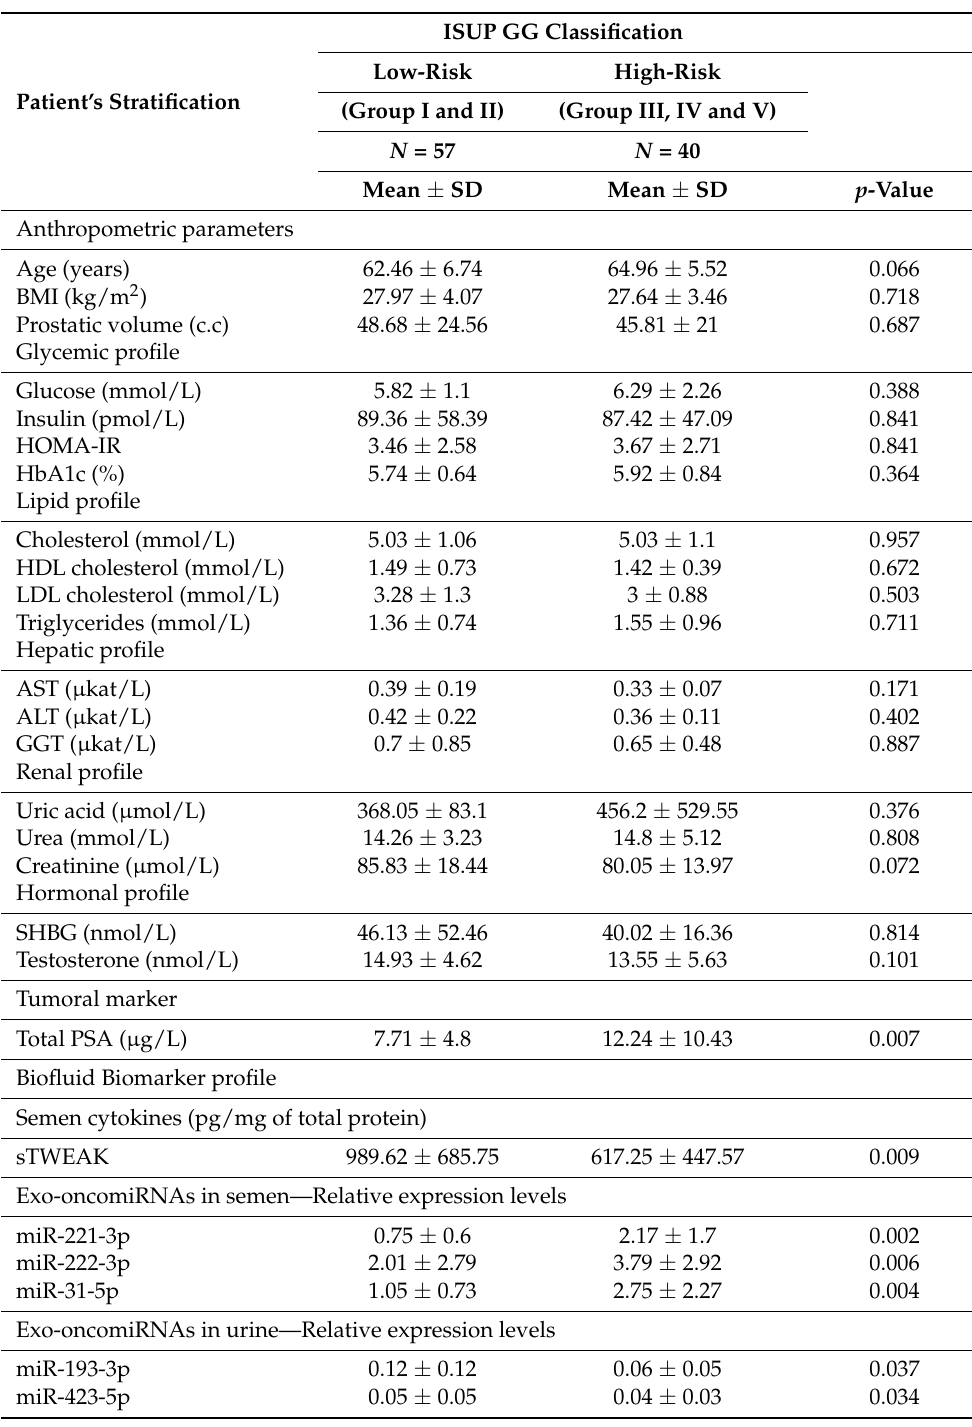
Table 2. Anthropometric and analytical characteristics according to ISUP-GG